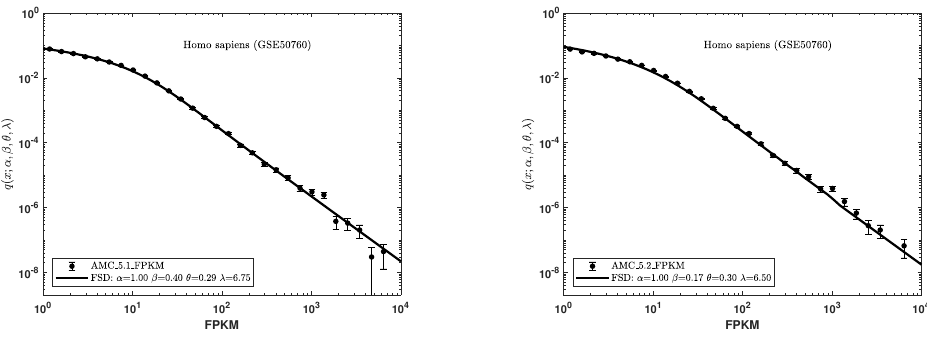
Figure A1. Probability density of gene expression obtained with the use of NGS technology. Dots are a density histogram of the experimental data on human tissue gene expression (GSE50760 series). The solid curve is the density (A1) for the specified parameter